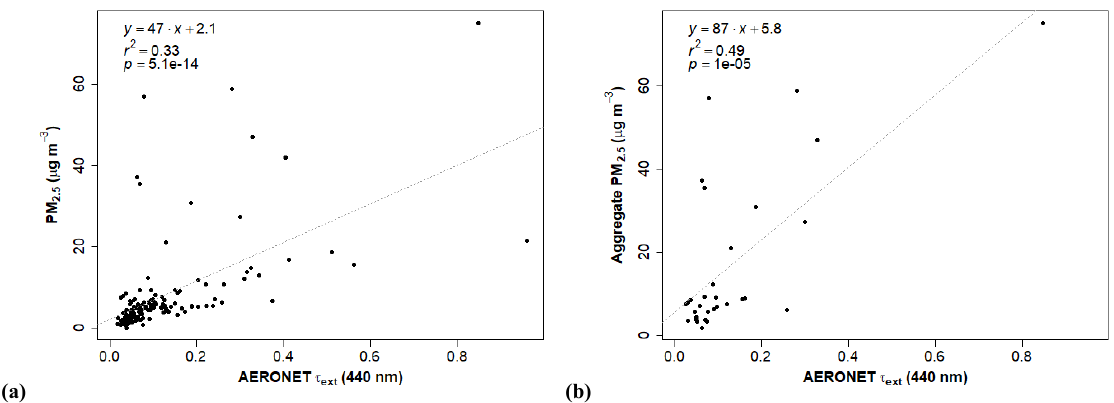
Figure 9. Aerosol Optical Depth (AOD, τ ext ) from the Cimel sun photometer located near the low-elevation site in Reno plotted against PM 2 . 5 (µgm − 3 ) at PEAV for (a) all data and (b) days with